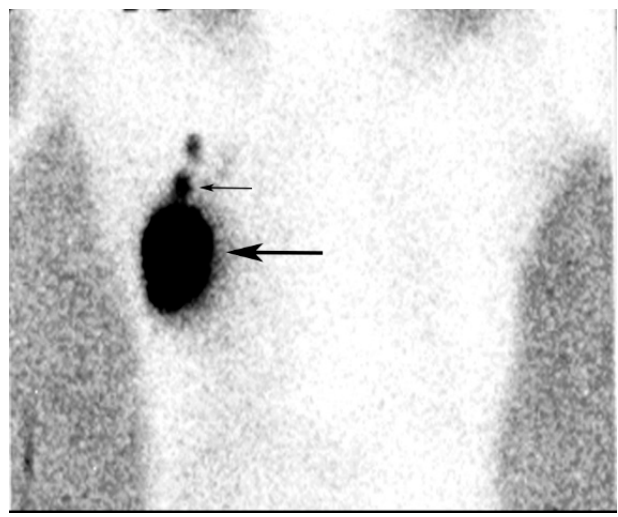
Figure 12. An injection site in the upper outer quadrant of the right breast (large arrow) is seen adjacent to a low axillary SLN (small arrow).